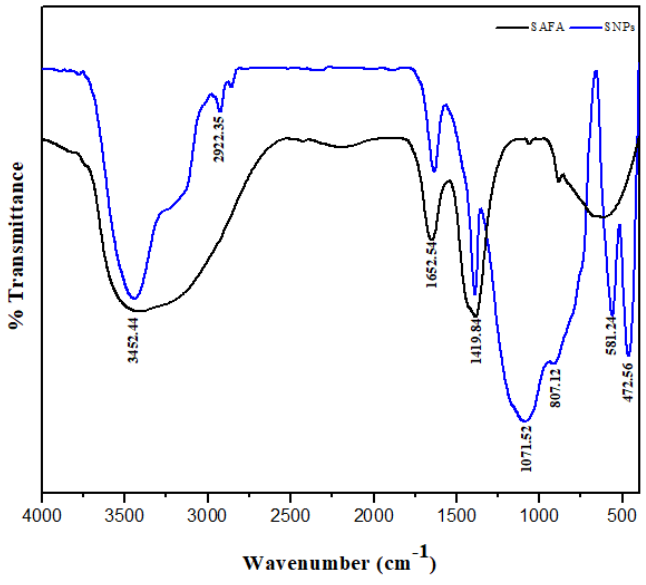
Figure 3. FTIR spectral of SAFA and extracted SNPs.